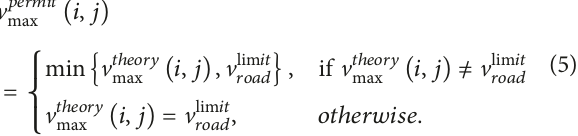
Figure 4: Schematic of the separation